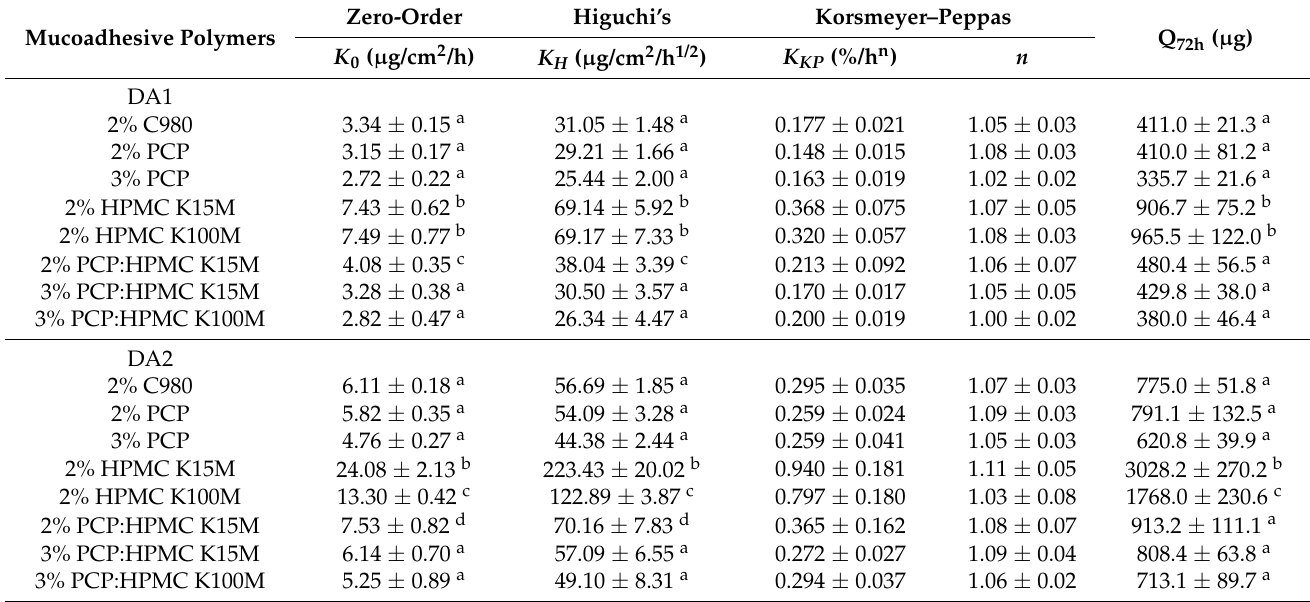
Table 4. Release parameters of DAs from various C. comosa mucoadhesive gels. Mucoadhesive